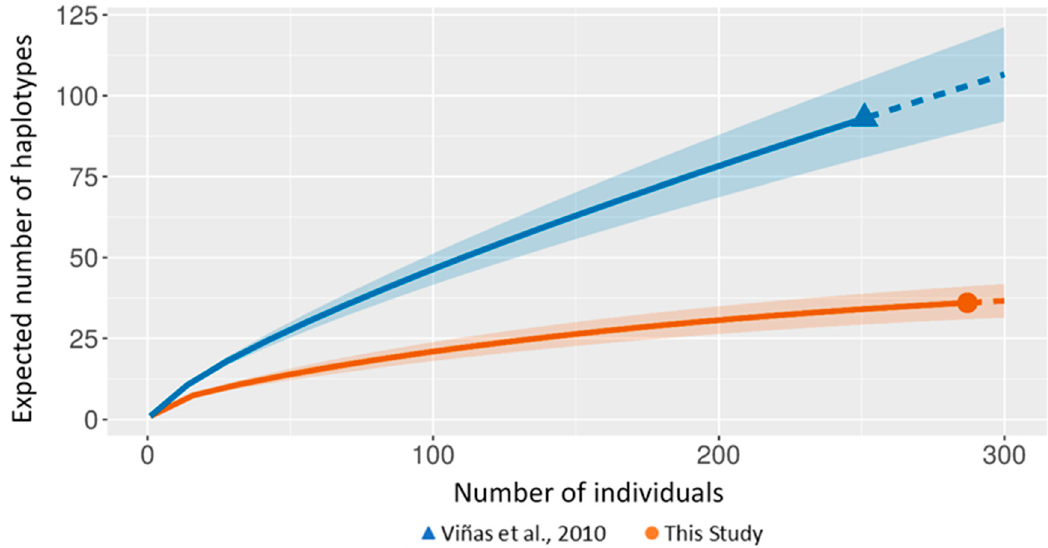
Figure 3. Size-based rarefaction (solid curves) and extrapolation (dashed curves) with 95% confidence intervals (shaded areas) comparing ancient Mediterranean swordfish (blue) and contemporary (orange) samples.